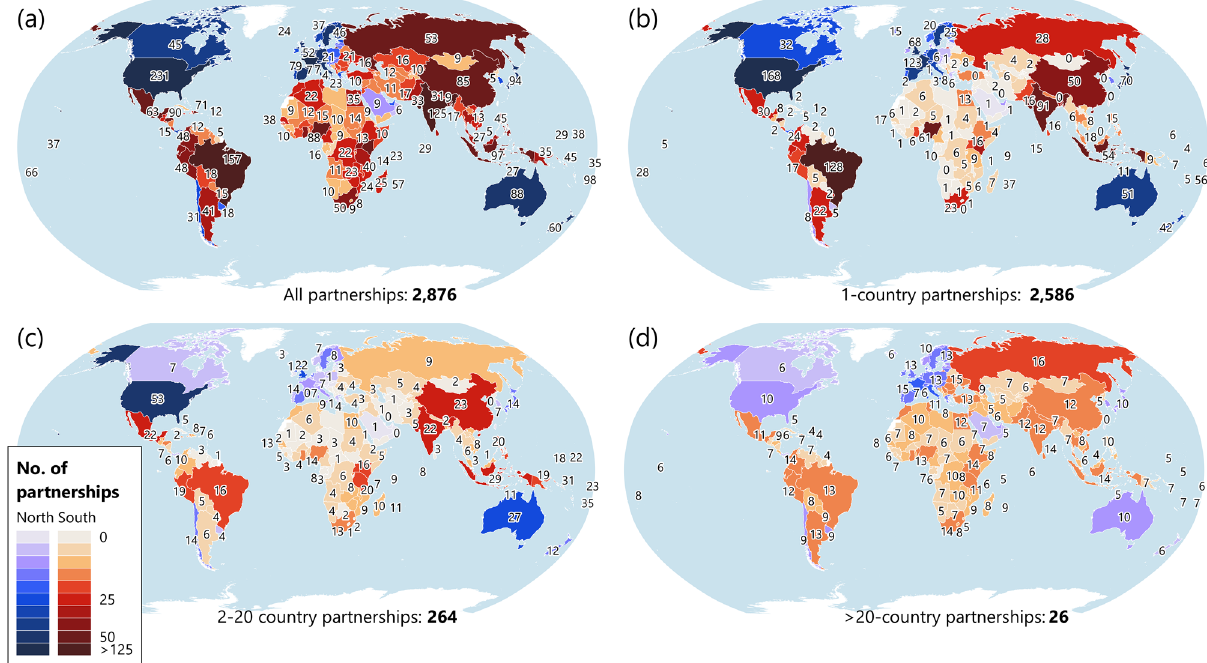
Figure 2. Distribution of the number of partnerships that specifically identified partners’ countries. Overview of the number of partnerships that specifically identified partners from: ( a ) one or more countries; ( b ) only one country, i.e. domestic partnerships; ( c ) 2 to 20 countries; and ( d ) more than 20 countries. Northern countries (high income) are shown in shades of blue; Southern countries (upper-middle, lower-middle and low income) are shown in shades of red. Maps generated in QGIS 3.12 (https:// qgis. org/). Larger versions of the components of this figure are included in Supplementary Material.